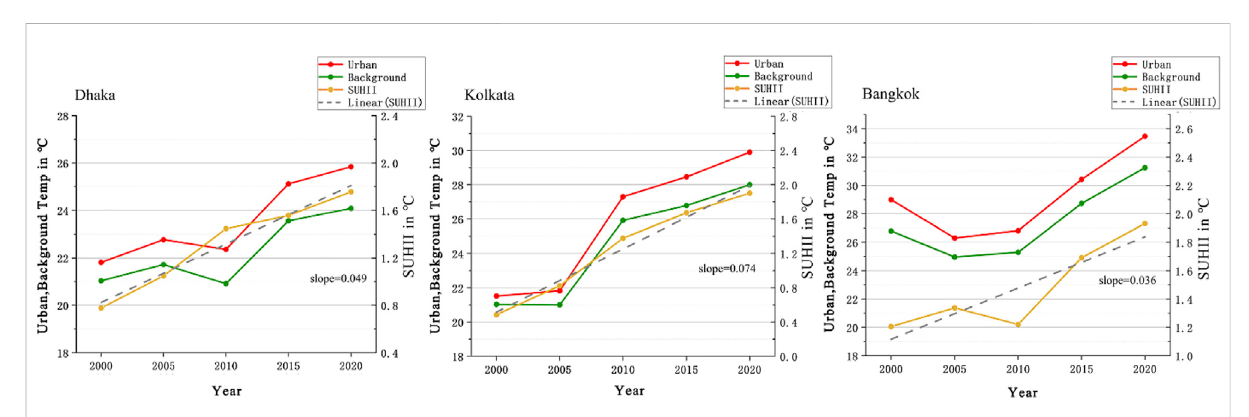
FIGURE 5 SUHII in the three megacities in 2000, 2005, 2010, 2015, and 2020.